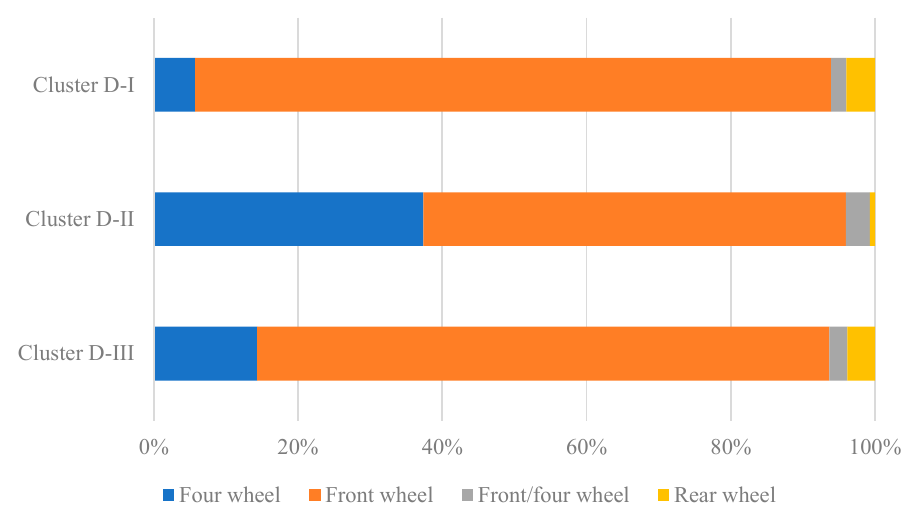
Figure 7. Percentages of HEVs by drive system for each cluster. Note that front-/four-wheel is a classification that could not distinguish between the front-wheel and four-wheel drive vehicle types.